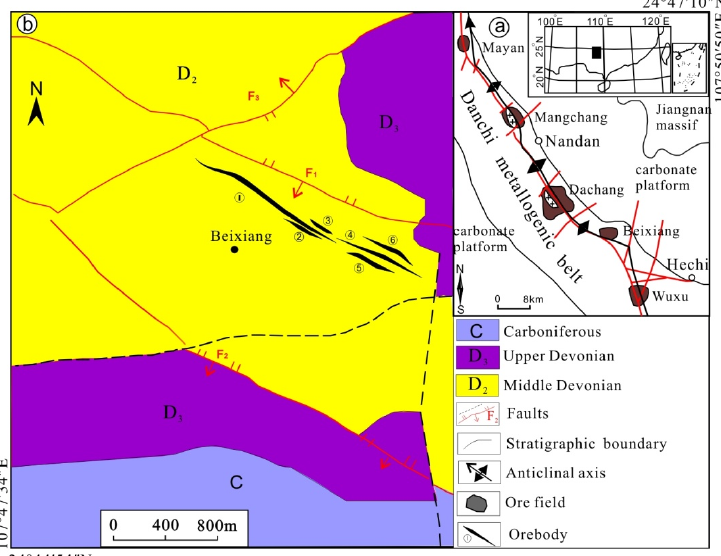
Figure 1. Sketch geological maps of the Danchi polymetallic belt ( a ) and the Beixiang deposit ( b )